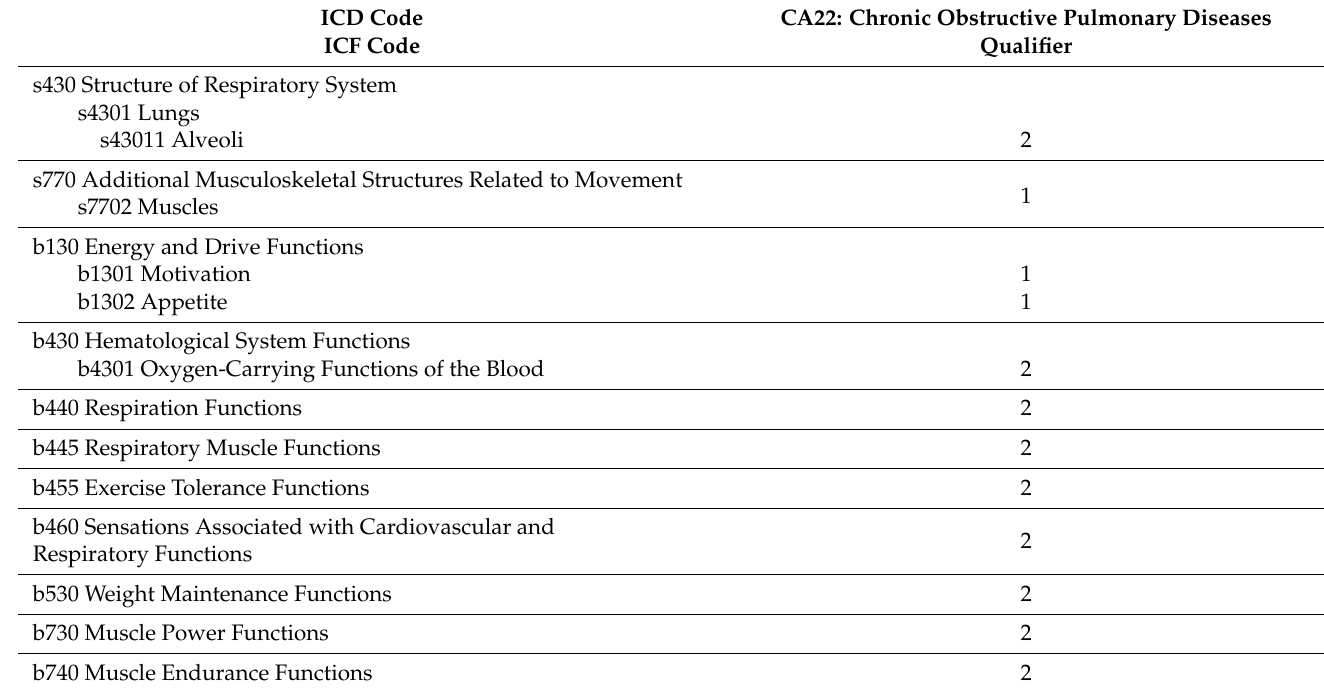
Table 1. ICD code and ICF codes and qualifiers describing the health condition of